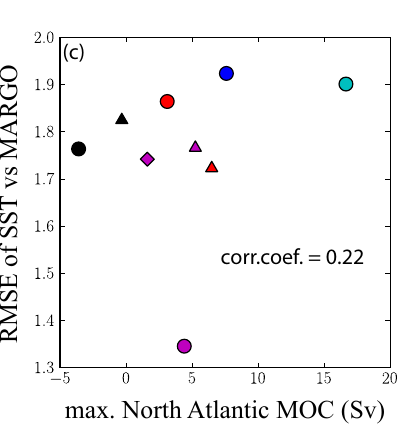
Fig. 10. Correlation between: the root mean square of the differ- ence in Atlantic SST between PMIP2 and MARGO scaled by the MARGO uncertainty; the maximum northward heat transport in the North Atlantic; and the maximum meridional overturning in the North